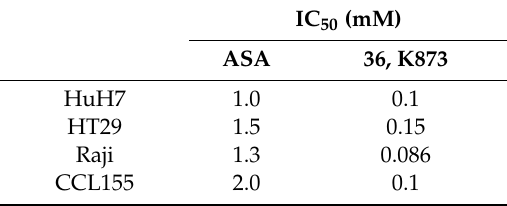
Figure 16. The 5-phosphate derivative K873. Table 11. The antiproliferative activities of the 5-phosphate derivative K873.